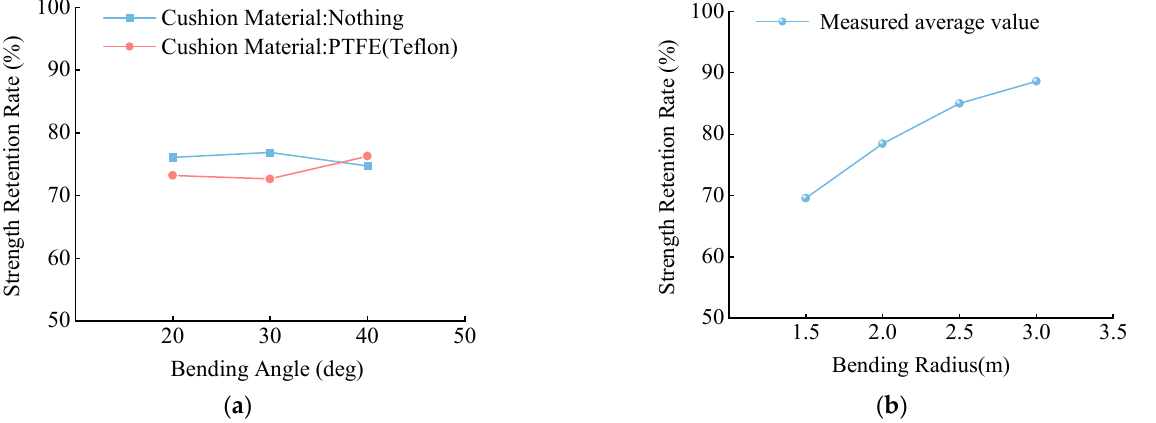
Figure 12. ( a ) Test results of CFRP tendons, ( b ) Test results of CFRP cable. Comparison of test results under different working conditions.